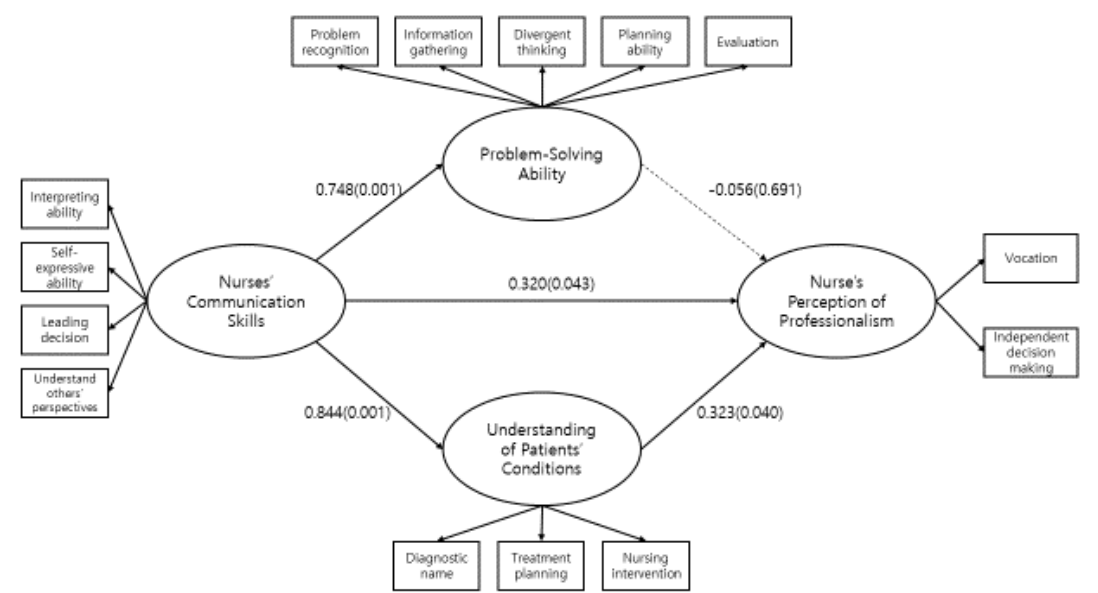
Figure 2. Final model. * χ 2 = 124.074 (df = 61, p < 0.001), GFI(Goodness of Fit Index) = 0.90, RMSEA(Root Mean Square Error Approximation) = 0.07, NFI(Normed Fit Index) = 0.87, IFI(Incremental Fit Index) = 0.93, TLI(Tucker-Lewis Index) = 0.91, CFI(Comparative Fit Index) = 0.92.